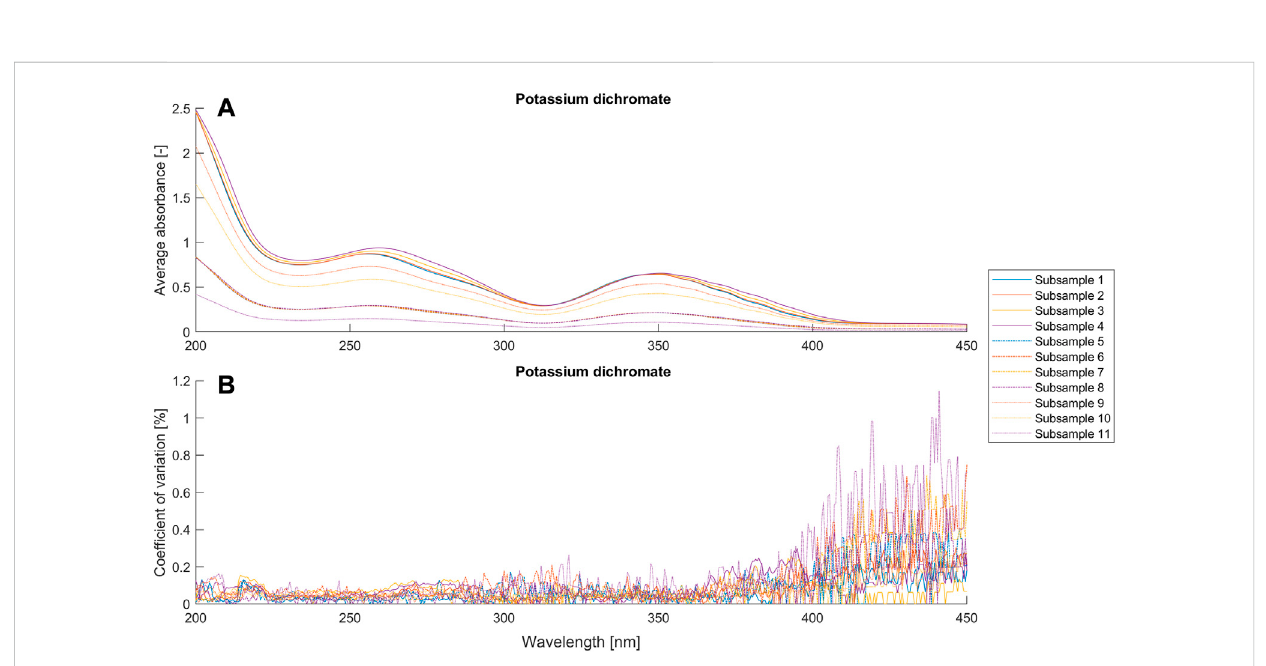
FIGURE 3 Average absorbance and coef fi cient of variance ( n = 9) for different setups (Table 1) of the potassium dichromate solutions.